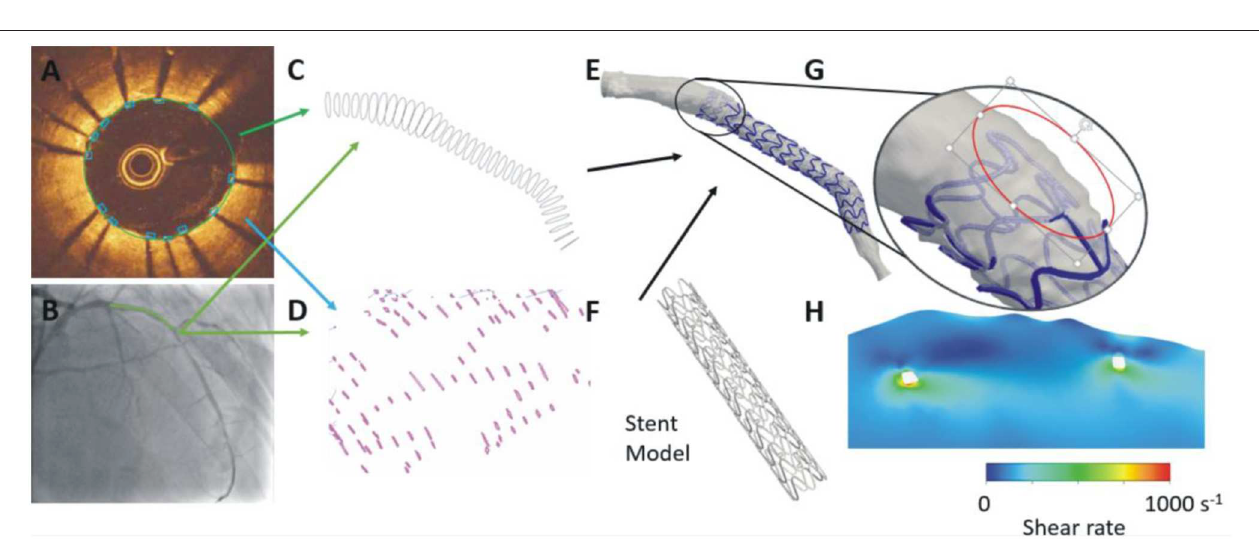
FIGURE 6 | Advanced methodology proposed for the reconstruction of stented segments. In each OCT frame the lumen border is detected and the location of the stent struts is annotated (A) . The OCT contours are placed perpendicularly onto the lumen centerline (B) extracted by two angiographic projections and the location of the side branches are used to estimate their absolute orientation (C) . A similar approach is used to estimate the location of the struts in 3D space (D) . A methodology that relies on the location of the stent struts in 3D space and on a priori knowledge of stent architecture is used to reconstruct the stent geometry that is fused with the lumen geometry to reconstruct the stented segment (E,F) . This approach enables accurate reconstruction of the protruded or malapposed struts (G) and evaluation of their implications on the local hemodynamic forces (H)